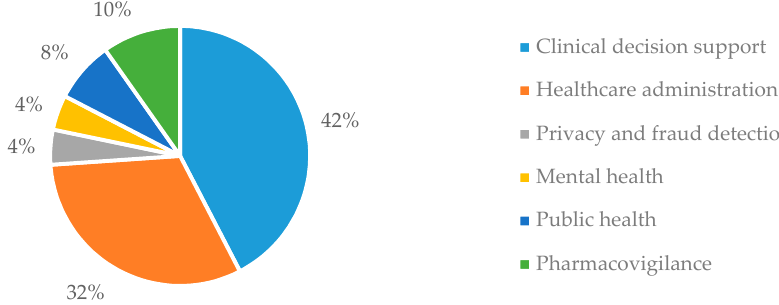
Figure 10. Percentage of papers utilized healthcare analytics by application area (92 articles out of 117).